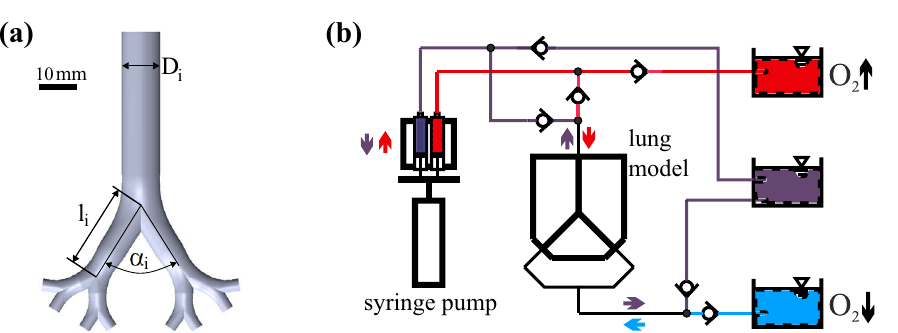
Figure 1. ( a ) Geometry of the lung model, ( b ) sketch of the experimental set-up illustrating the flow paths between the syringe pump and the storage liquid containers. Red colors denote initial high concentration, blue low concentration, purple is a mixed